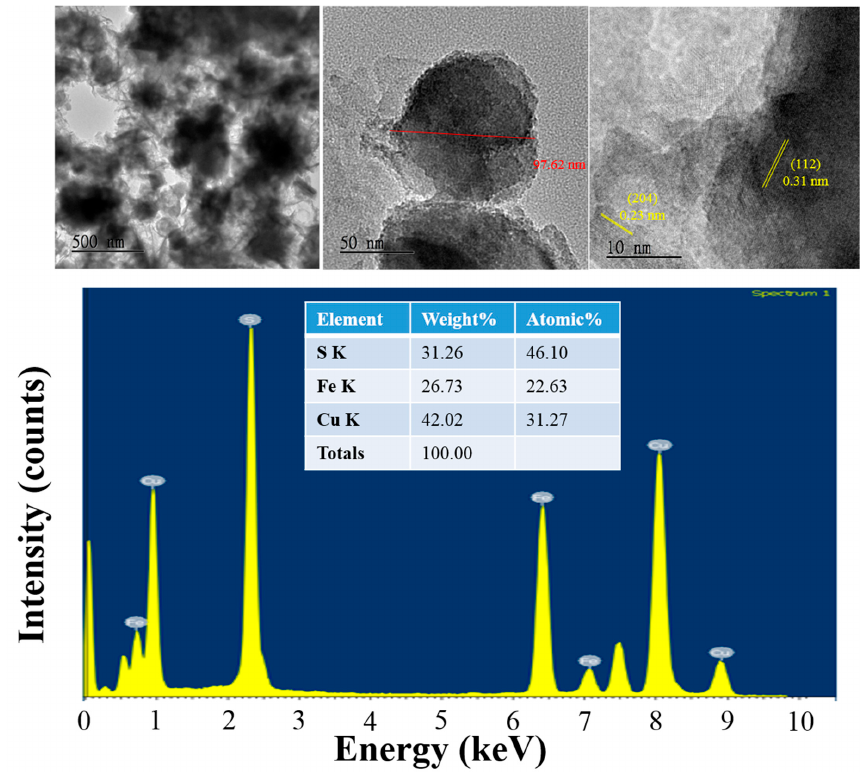
Figure 3. TEM images and EDS spectra of C-CuFeS 2 samples. XRD was used to investigate the crystal structure of the prepared CuFeS 2 samples. The XRD patterns of the prepared CuFeS 2 samples are shown in Figure 4A. The diffraction peaks at 29.5°, 49.1°, and 58.6° were identified and assigned to the (112), (204), (312), (204), and (312) faces of the tetragonal chalcopyrite CuFeS 2 , respectively (PDF 83-0983). Through the Scherrer equation, the average crystal size of H-CuFeS 2 and C-CuFeS 2 was 20.36 and 11.2 nm, respectively. The Raman spectra of the prepared CuFeS 2 samples are shown in Figure 4B. The Raman shifts at 212 cm − 1 , 276 cm − 1 , and 379 cm − 1 correspond to the S ele- ment, Cu(I)-S, and Fe(III)-S stretching vibration, respectively.